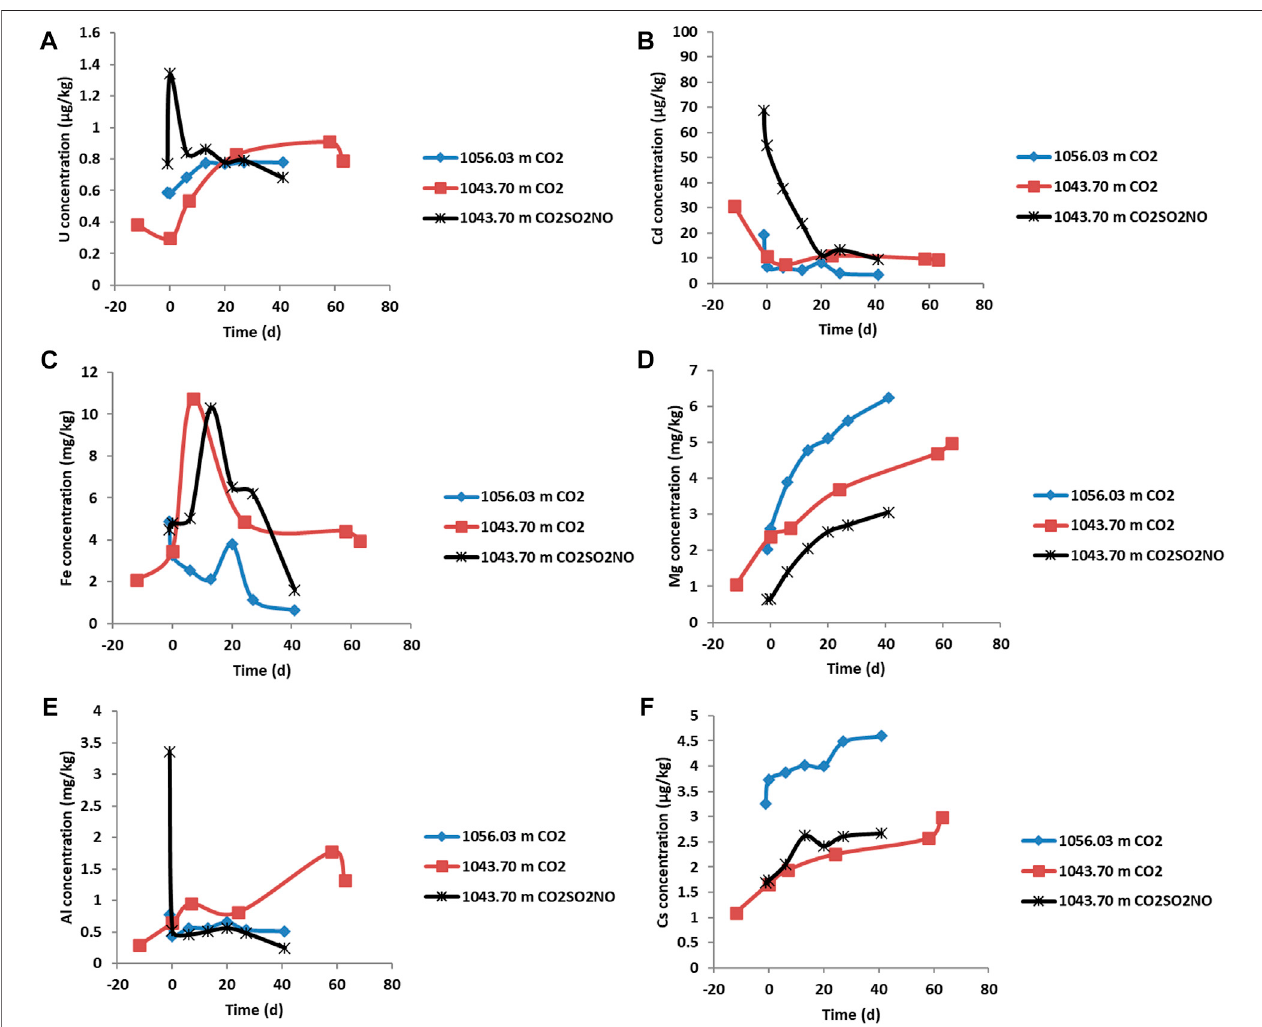
FIGURE 9 | Dissolved element concentrations during the reactions of Evergreen Formation core. The negative time points represent the water composition and water rock interaction, and the CO 2 gas was introduced at time zero. (A) Concentration of U (µg/kg), (B) Cd (µg/kg), (C) Fe (mg/kg), (D) Mg (mg/kg), (E) Al (mg/kg), and (F) Cs